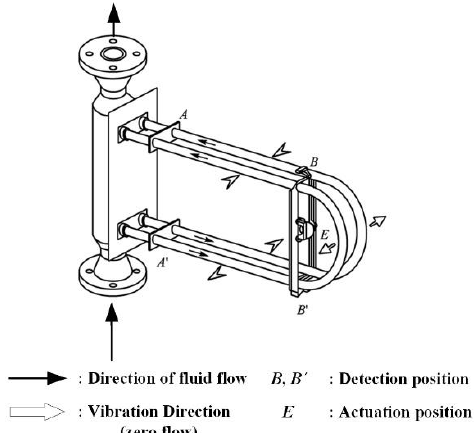
Figure 2. Structure diagram of a U-tube Coriolis mass flowmeter. 91